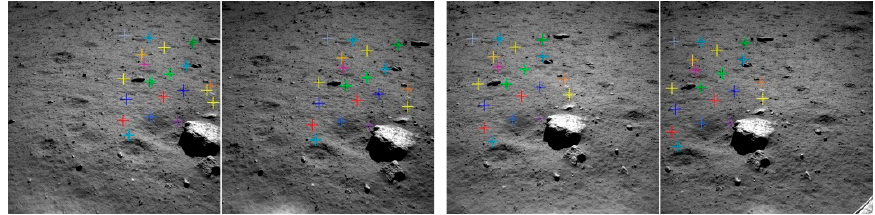
Figure 17. Distribution of control points on the lander and the solar panel of rover.